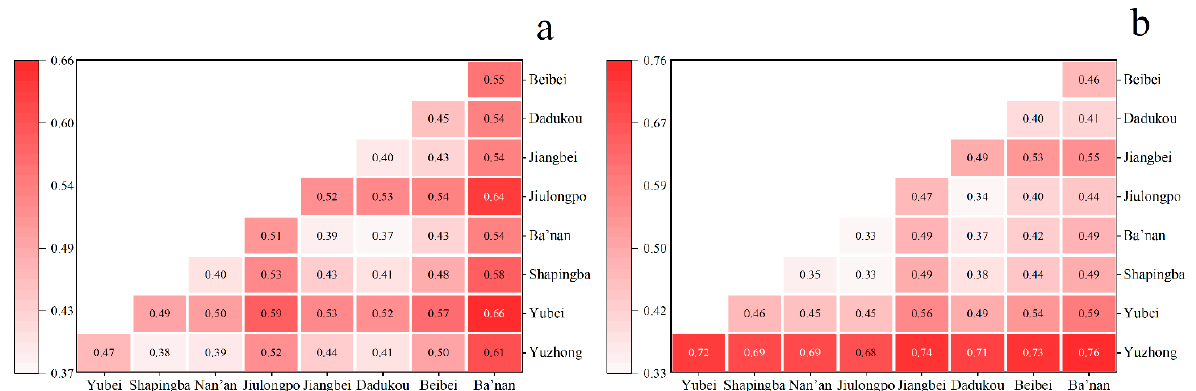
Figure 9. Inter-regional differences of The Dagum Gini coefficient. ( a ) service capacity; ( b ) space utilization.